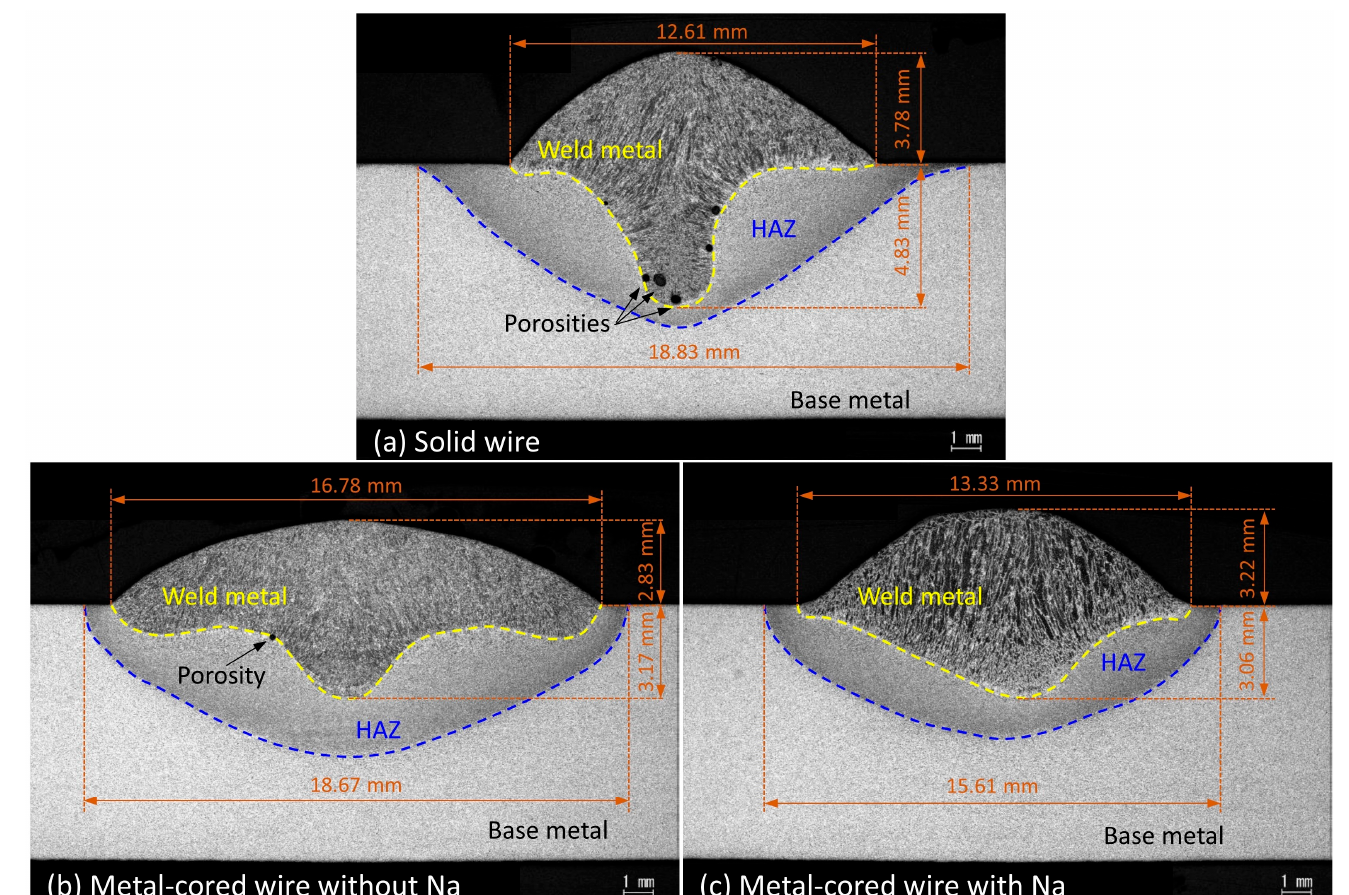
Figure 11. Weld bead